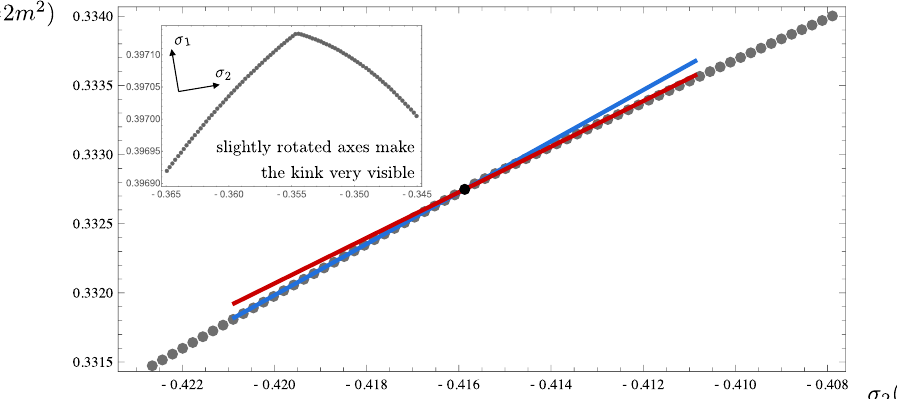
Figure 9 . The zoomed-in view of the less sharp kink of NLSM. The circles here are the points on the boundary of the slate and the red and blue lines are the tangents on two side of the NLSM kink at ( (cid:27) 2 ; (cid:27) 1 ) (cid:25) ( (cid:0) 0 : 4159 ; 0 : 3327). The plot in the inset is the same as in the big one except for a simple small rotation of the axes (by 9 : 5 degrees which is the approximate slope near the NLSM) which renders the NLSM kink much easier to